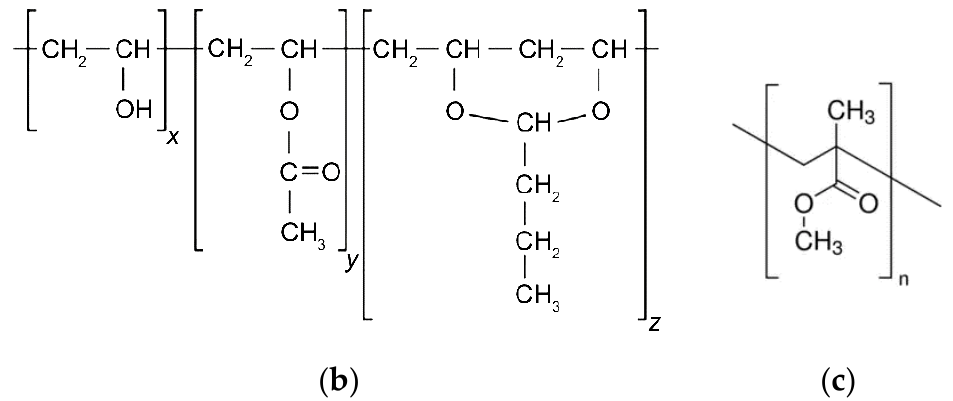
Figure 1. Chemical structures of the used main binder components: ( a ) polyethylene glycol (PEG); ( b ) poly(vinylbutyral) (PVB); ( c ) poly(methylmethacrylate) (PMMA). Table 1. Overview of the used binder components (T S : softening temperature, T D : decomposition temperature).